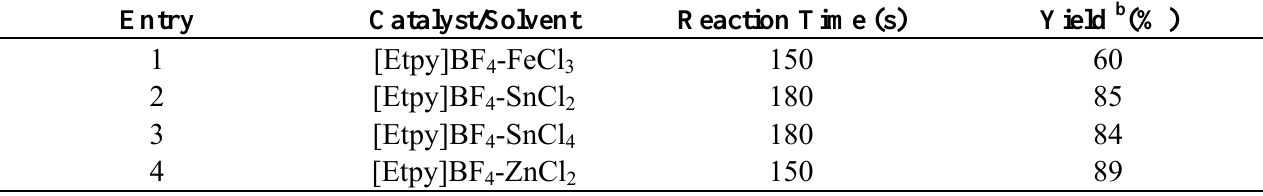
Table 4. Catalytic activities of alkylation reactions with various ionic liquids in microwave heating a .